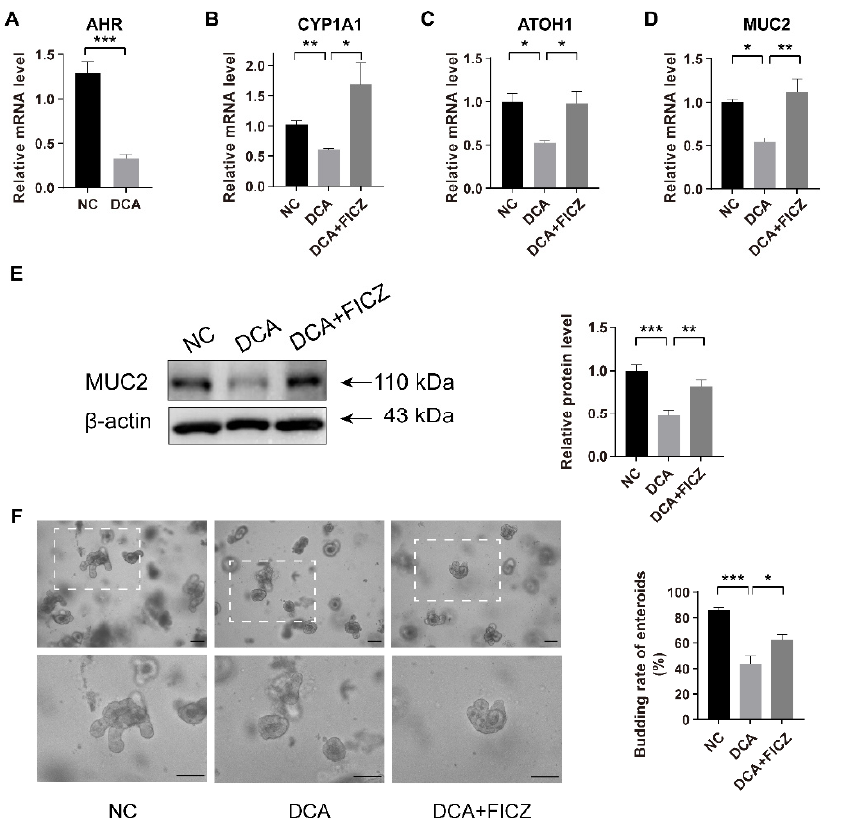
Figure 4. Supplementation with AHR agonists rescues DCA ‐ induced damage to ISCs differentia ‐ tion. ( A – D ) Relative mRNA expression levels of AHR ( A ), CYP1A1 ( B ), ATOH1 ( C ), and MUC2 ( D ) in isolated crypts cultured with different administrations for 24 h (n = 4). ( E ) Relative protein levels and analysis of MUC2 in isolated ileal tissue cultured with different treatments for 24 h (n = 6). ( F ) Representative images of intestinal enteroids and analysis of enteroid budding rates after culturing for 72 h in different groups (n = 3); scale bars, 100 μ m. Data are shown as the mean ± SEM. AHR, aryl hydrocarbon receptor; ISCs, intestinal stem cells; ATOH1, atonal homologue 1; NC, negative control; DCA, deoxycholic acid; FICZ, 6 ‐ formylindolo[3,2 ‐ b]carbazole. * p < 0.05; ** p < 0.01; *** p < 0.001.